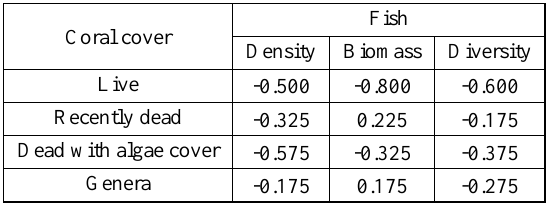
Table 2. Spearman rank correlation test results (r) for coral cover and fish variables from the 2006 dataset The Spearman rank correlation test further indicates weak relationship between fish variables (2014 dataset) and selected landscape metrics. Based on the values of Spearman’s correlation coefficient, moderate positive relationships were found at the geomorphological level